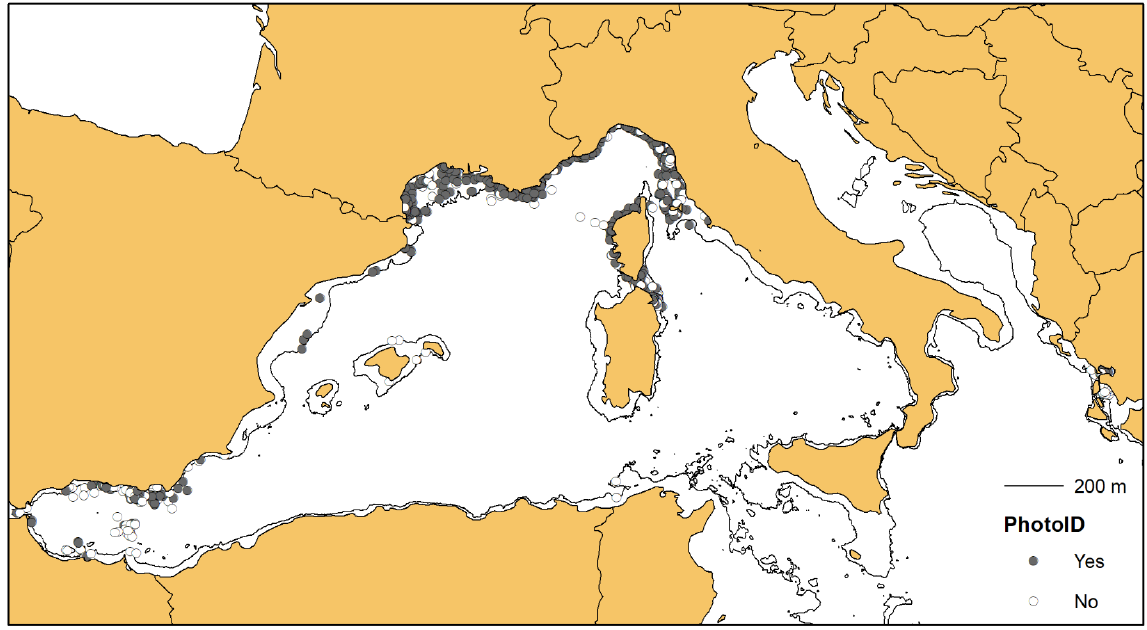
Figure 4. Of the 3927 sightings of bottlenose dolphins, 2007 produced photo-identification data (see the dark points). Table 3. The result of the matching between photo-ID catalogues (the number of individuals shared across the different catalogues) and relative SRI between catalogues (in parentheses). The SRI can vary from 0 (no individuals shared between catalogues) to 1 (all the individuals in the first catalogue are present in the second one and vice versa). In green the cells with SRI > 0, in orange the cells with SRI > 0.1.